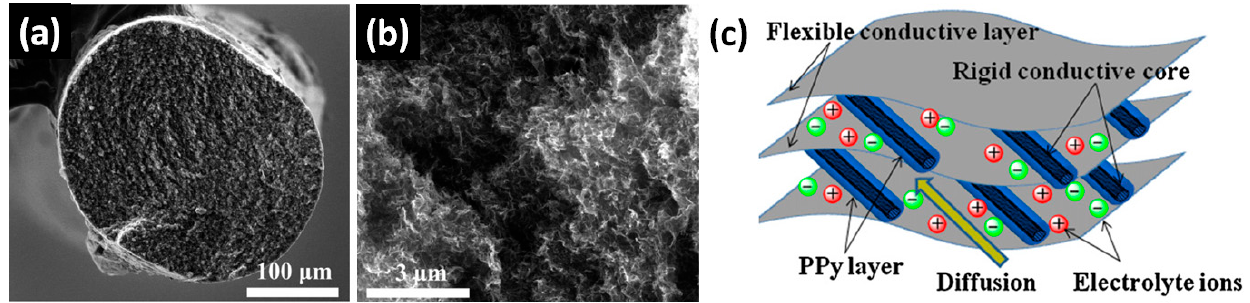
Figure 13. Cross-sectional SEM image of the rGO/MWCNT fibre at low ( a ) and high ( b ) magnifications (Reproduced with permission of [34]. Copyright American Chemical Society, 2017). Schematic representation of the microstructure and energy storage characteristics of the rGO-CNT-polypyrrole (PPy) film ( c ) (Reproduced with permission of [35]. Copyright Elsevier, 2011).